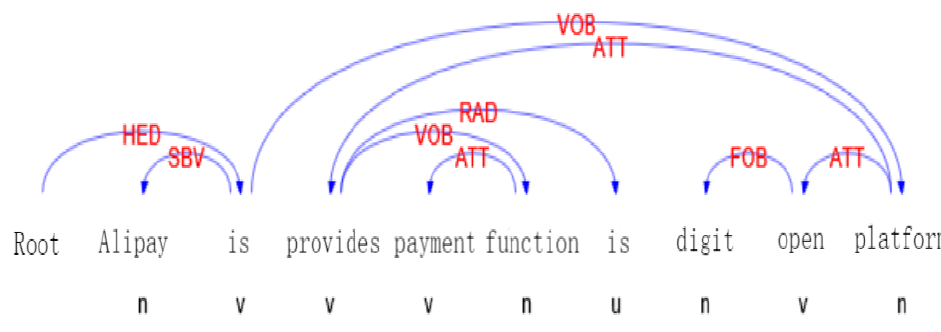
Figure 2. LTP processing result of application information.